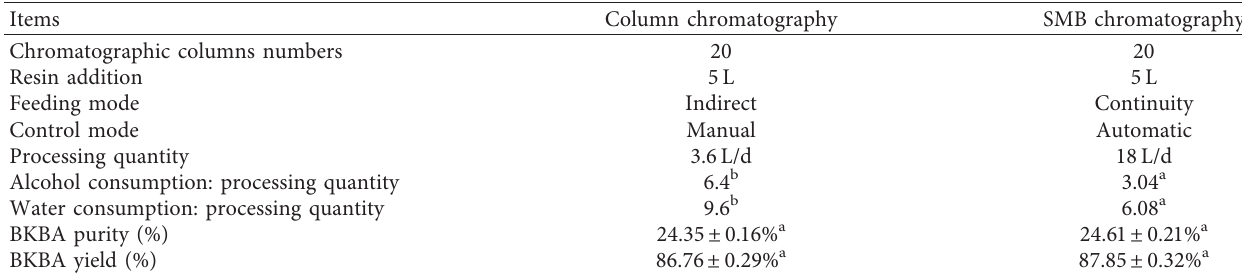
Table 3: Comparison of TMB and